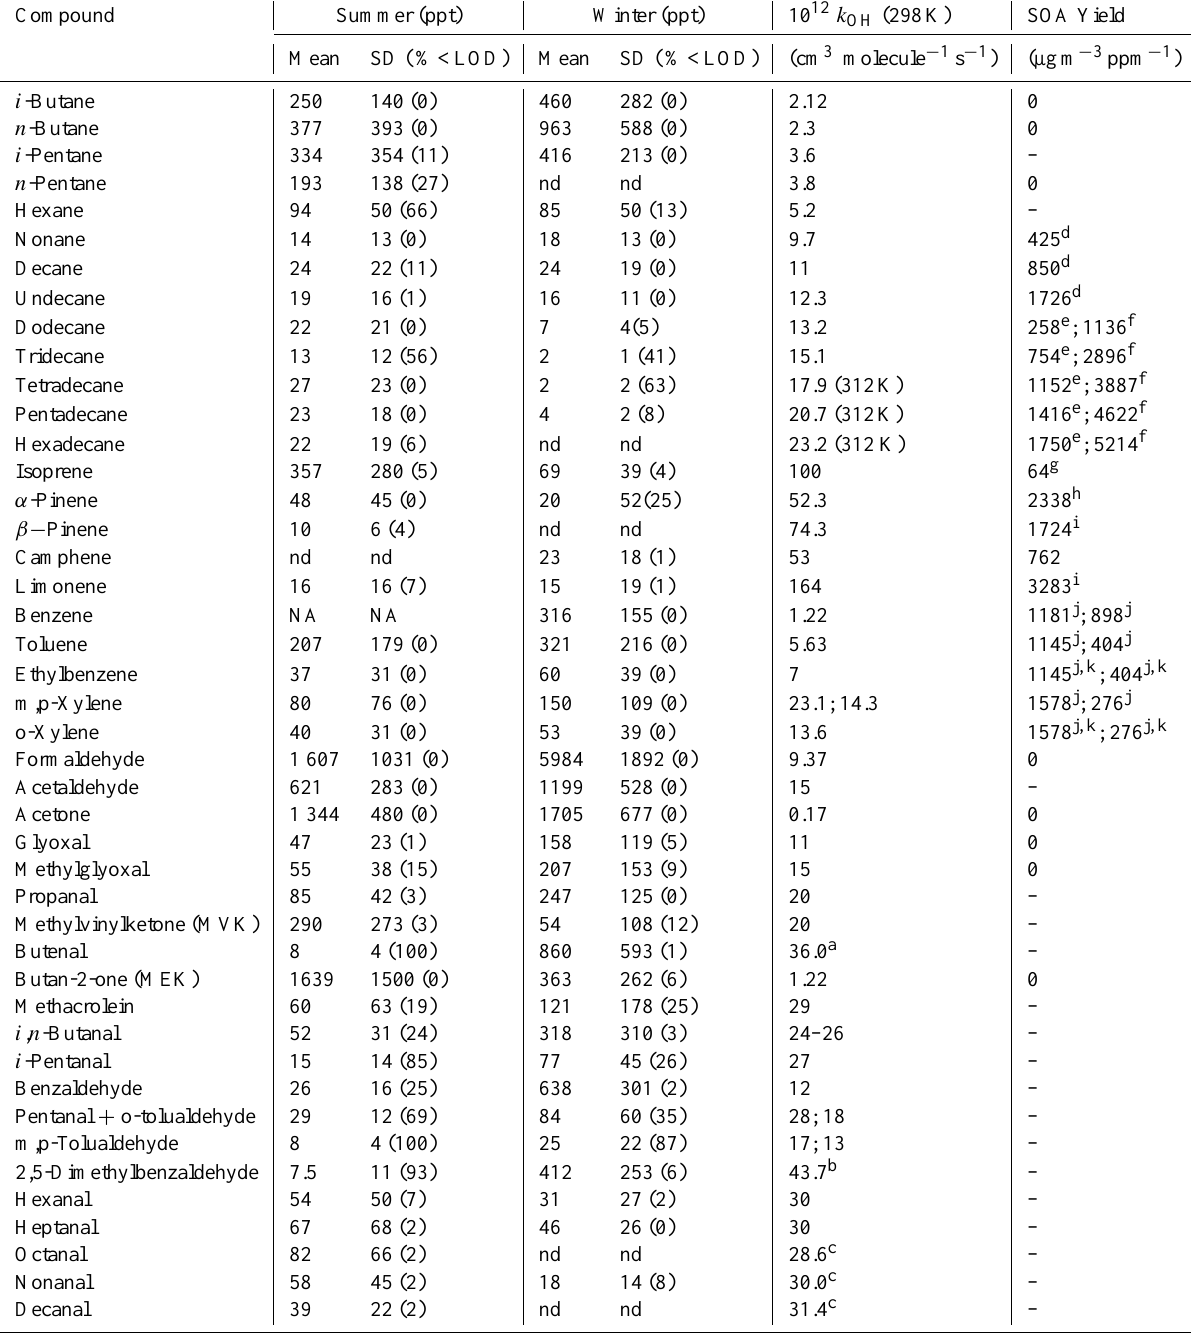
Table 3. Summer and winter mean concentrations, standard deviation (SD), percentage of values below limit of detection (%<LOD), rate constant with OH (kOH; when not indicated: Atkinson and Arey, 2003) and SOA yield formation (when not indicated: Seinfeld and Pandis, 1998) of the VOCs measured in suburban Paris